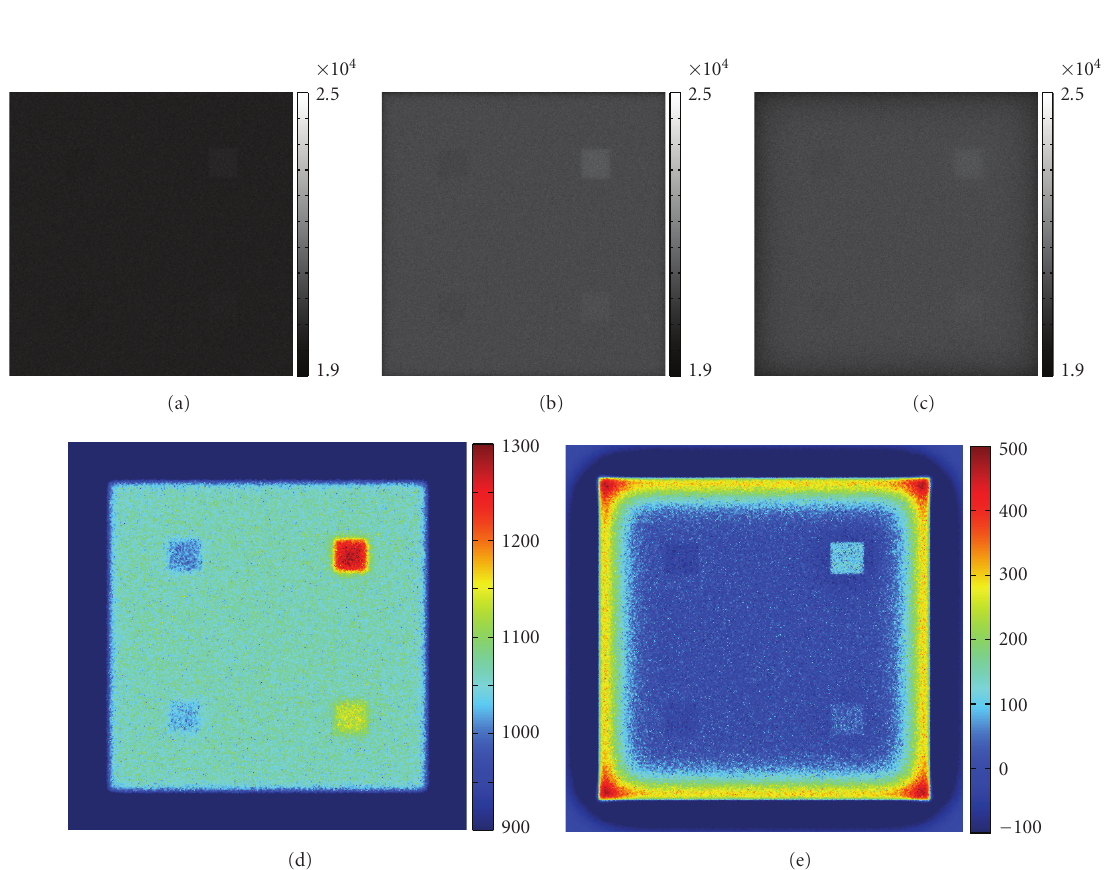
Figure 4: Numerical results on X-ray small-angle scattering imaging. (a) An image collected with a high collimation aspect and a small object-detector distance (2.5cm), (b) an image with a low collimation aspect and a small object-detector distance (2.5cm), (c) an image with a low collimation aspect and a large object-detector distance (17.5cm), (d) the di ff erence between (a) and (b), and (e) the di ff erence between (b) and